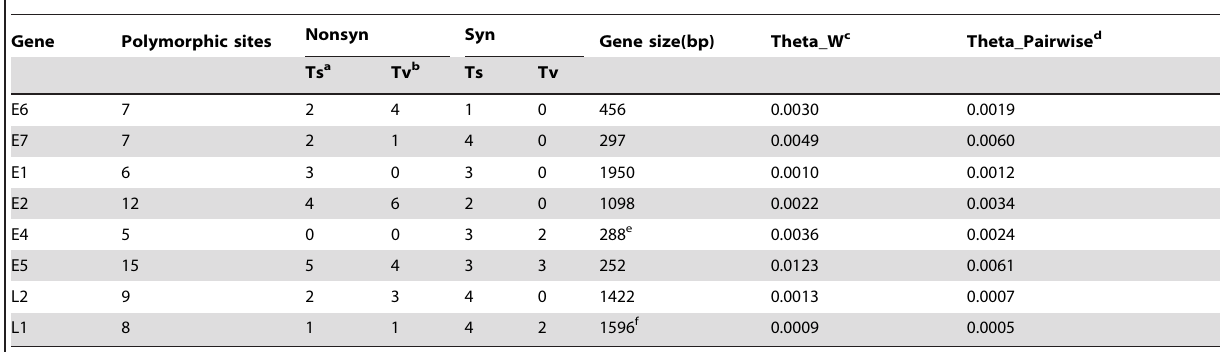
Table 1. Summary of the polymorphisms in HPV genes